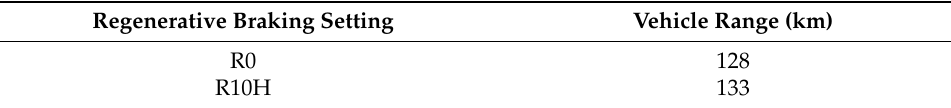
Table 5. Vehicle range measurement under legislative cycle.